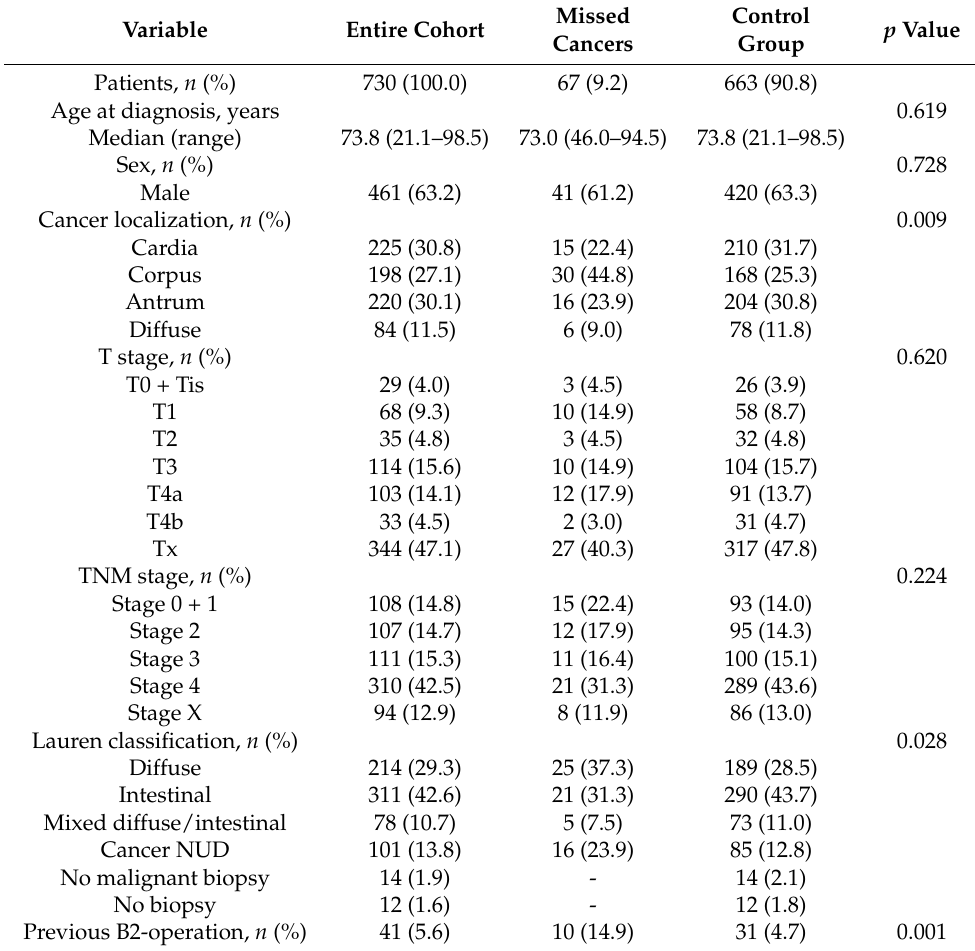
Table 1. Patient